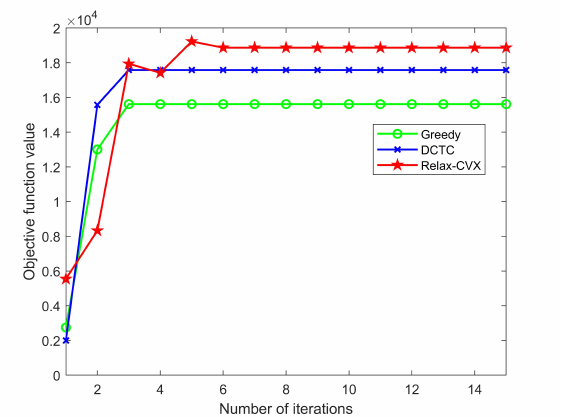
Figure 3. The objective function values versus the number of